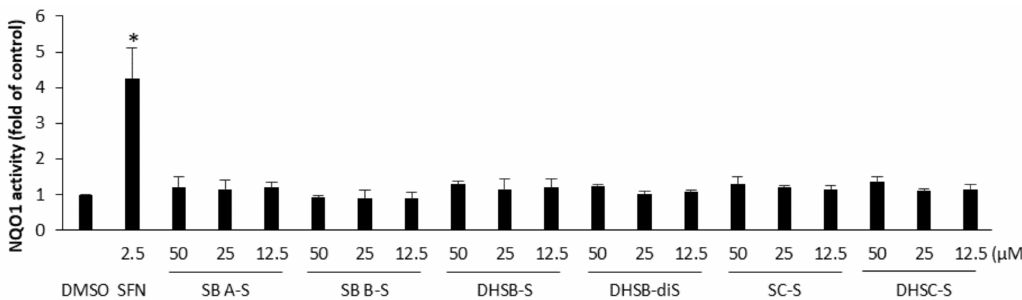
Figure 5. Effect of tested sulfated flavonolignans on NAD(P)/quinone oxidoreductase 1 (NQO1) activity in Hepa1c1c7 cells. Cells were treated for 48 h with 0.1% dimethylsulfoxide (DMSO) (control); 2.5 µ M sulforaphane (SFN; positive control); or with indicated concentrations of silybin A 20- O -sulfate (SB A-S), silybin B 20- O -sulfate (SB B-S), 2,3-dehydrosilybin-20- O -sulfate (DHSB-S), 2,3-dehydrosilybin- 7,20-di- O -sulfate (DHSB-diS), silychristin-19- O -sulfate (SC-S), or 2,3-dehydrosilychristin-19- O -sulfate (DHSC-S). After treatment, the activity of NQO1 was determined using the NQO1 assay. Data are means ± standard deviation of three experiments. p < 0.05 (*) significantly increased versus